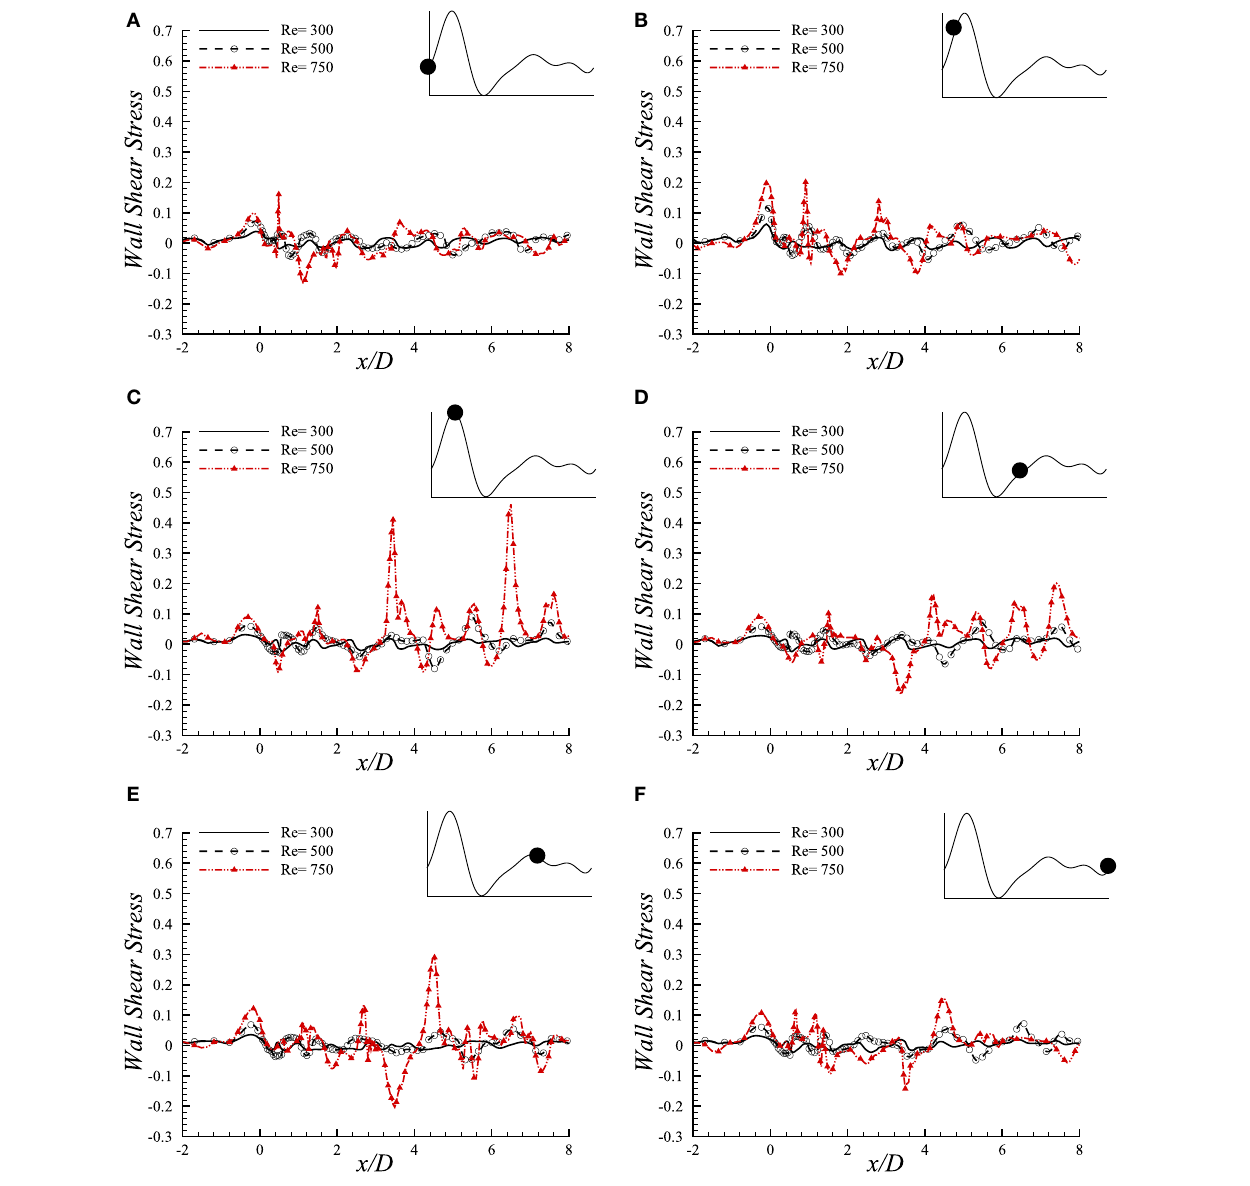
FIGURE 10 | Upper-wall shear stress, τ w / ρ U 2 , at different physiological phases (A) t / T = 9.0, (B) t / T = 9.1, (C) t / T = 9.2, (D) t / T = 9.5, (E) t / T = 9.7, (F) t / T = 9.10 when aneurysm = 100% dilated and stenosis = 60% constricted for various Reynolds numbers, i.e., Re = 300, Re = 500, and Re = 750 where the amplitude of wall oscillation, A = 3 (cid:2) 10 (cid:0) 4